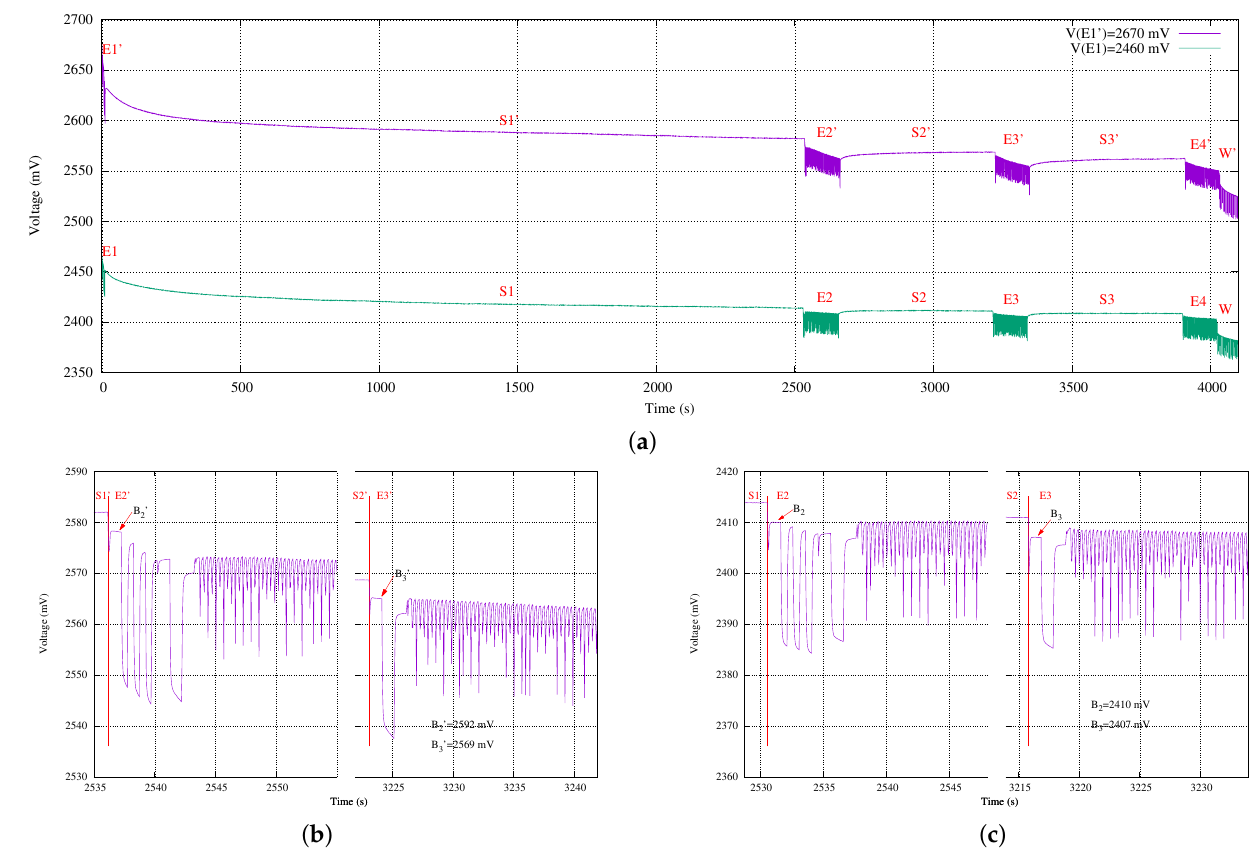
Figure 14. Two experimental tests — behavior comparison for different initial charge levels. ( a ) Comparison between tests. ( b ) Detail of recovery effect in the sensor node starting with a higher level of charge. ( c ) Detail of recovery effect in the sensor node with a lower level of